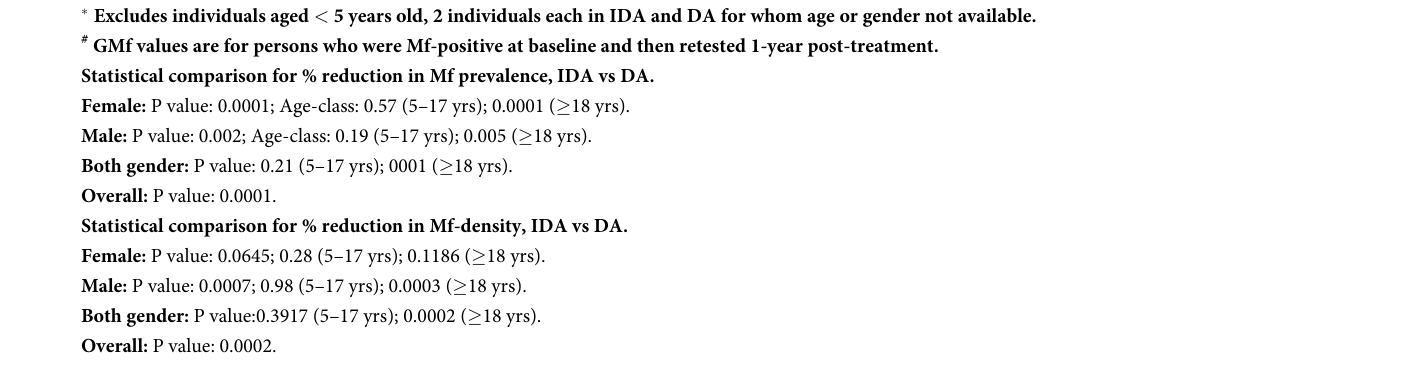
� Excludes individuals aged < 5 years old, 2 individuals each in IDA and DA for whom age or gender not available. # GMf values are for persons who were Mf-positive at baseline and then retested 1-year post-treatment. Statistical comparison for % reduction in Mf prevalence, IDA vs